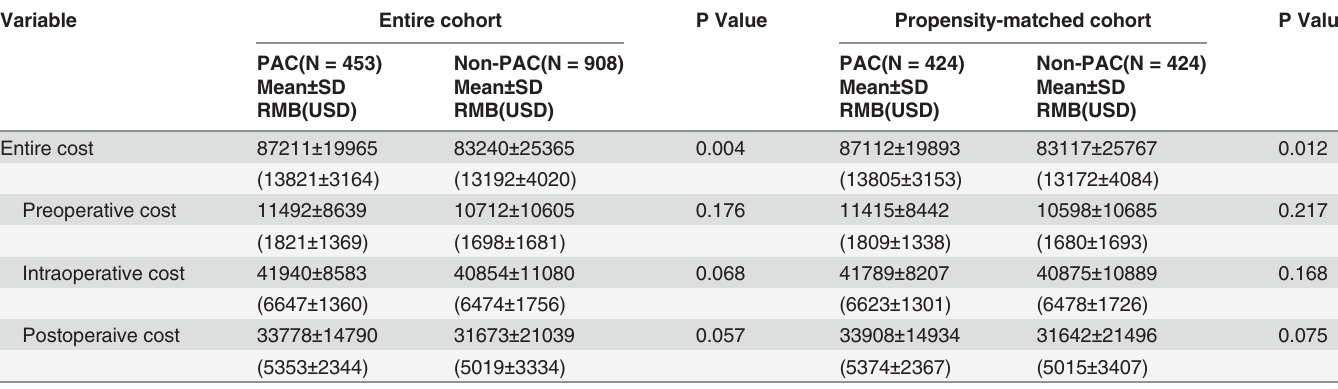
Table 6. In-hospital